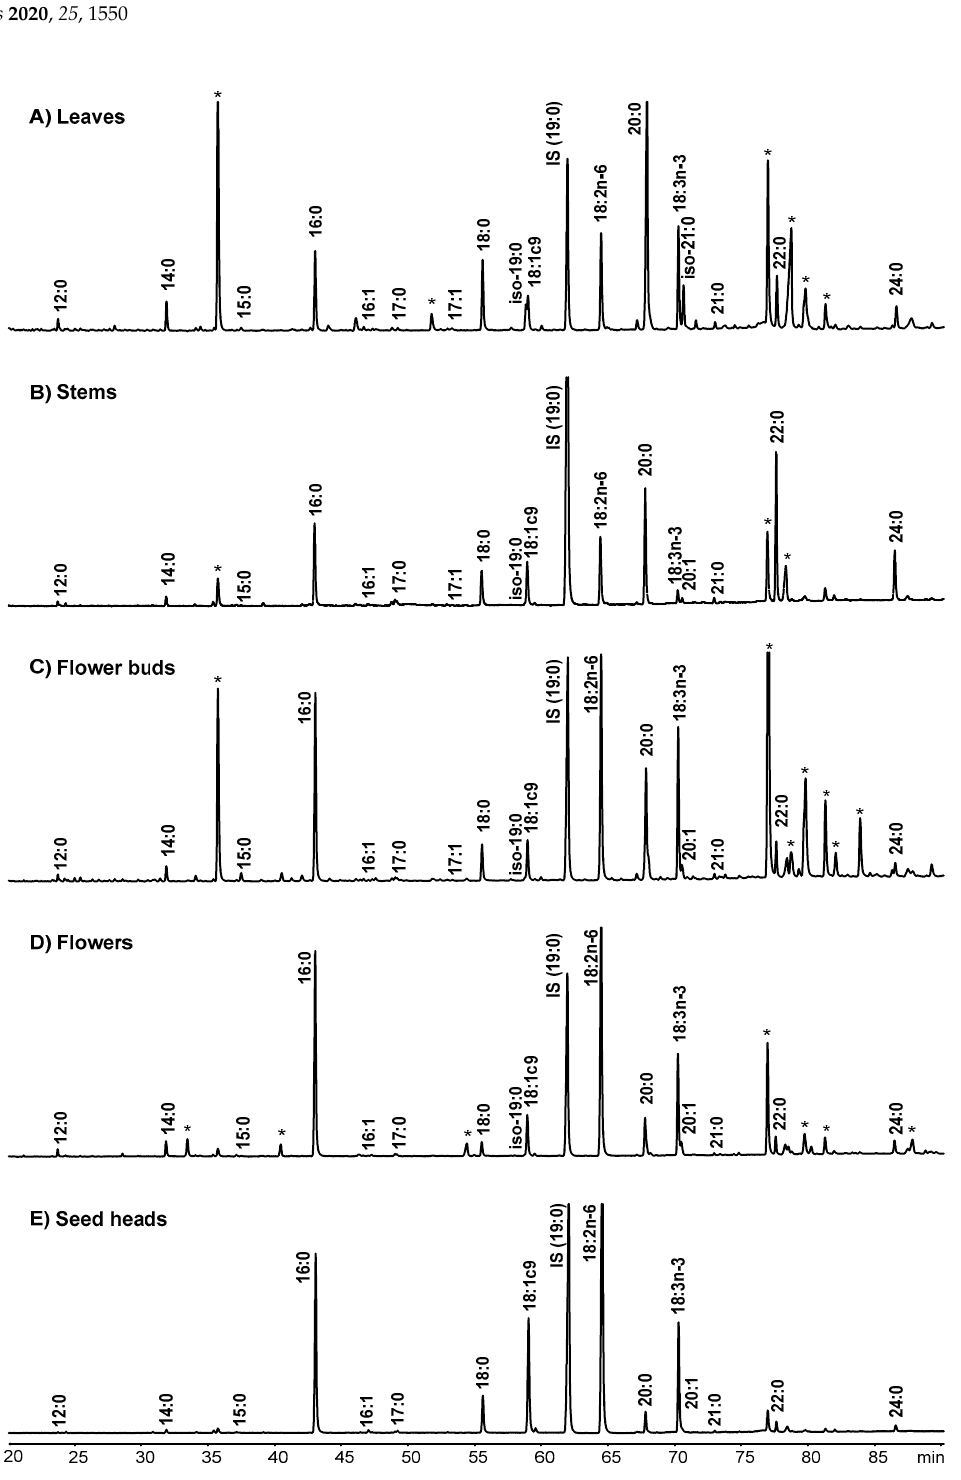
Figure 1. Partial gas-liquid chromatogram of the fatty acid methyl esters using a SP-2560 capillary column. A ) Cistus ladanifer leaves; B ) C. ladanifer stems; C ) C. ladanifer flower buds; D ) C. ladanifer flowers; E ) C. ladanifer seed heads (*, non-fatty acid compounds).